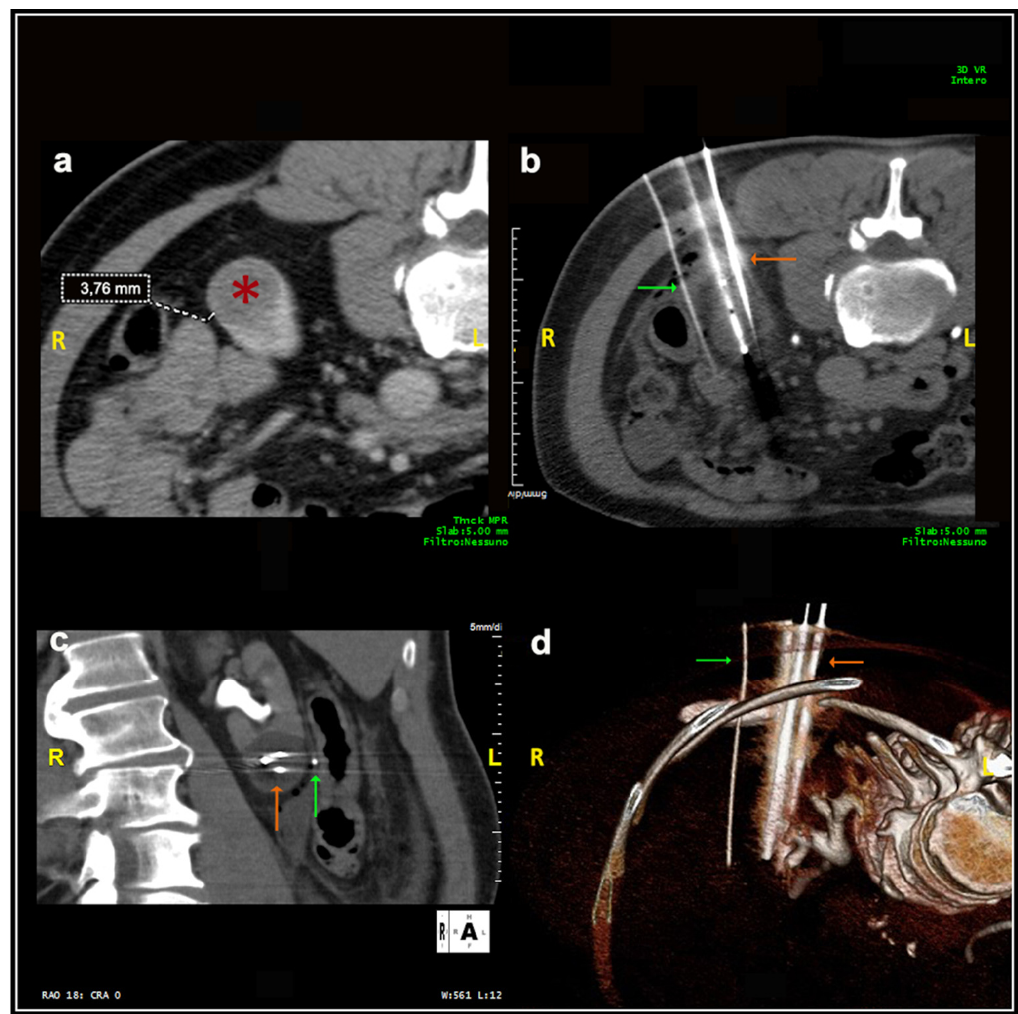
Figure 2. Male, 75 years old. Hydrodissection technique. ( a ) At the initial scan, the distance between the lesion ( * ) and an intestinal loop was 3.76 mm, significantly inferior to the safety margin of 1 cm required. ( b ) A 16G needle cannula (green arrow) was inserted for the injection of sterile water to increase the distance between the structures. The lesion was adequately treated with three cryoprobes (orange arrow). ( c , d ): Coronal plane and 3D reconstruction images, respectively.